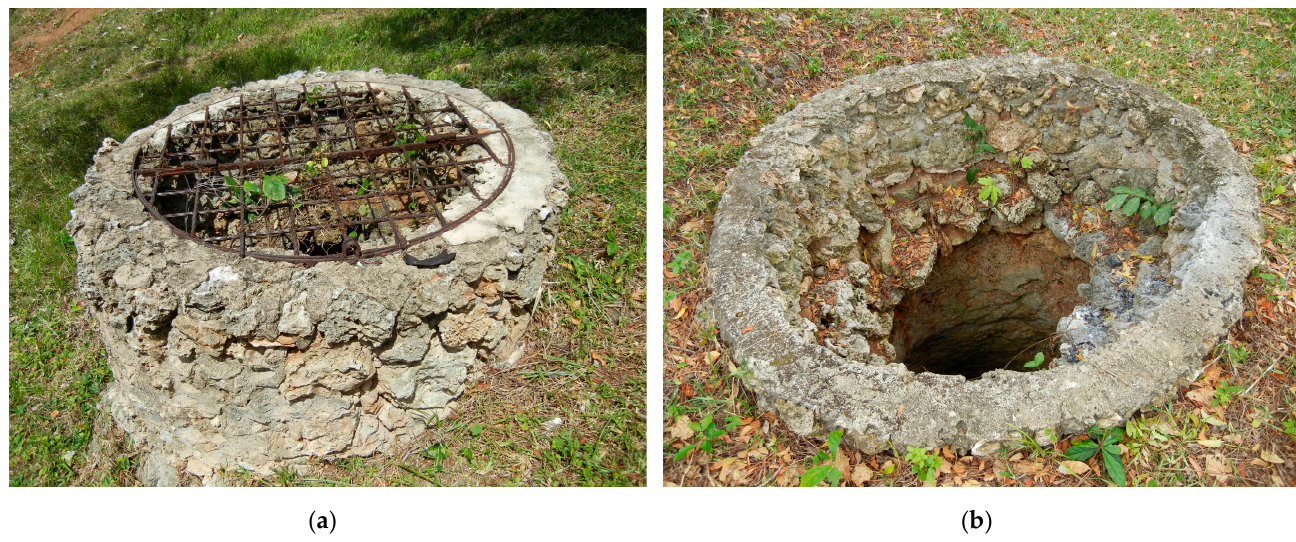
Figure 4. Examples of some types of wells in the precolonial town of Jumba la Mtwana, Kenya. Photos by the author, 2021. ( a ) A well near the center of the town. ( b ) An example of a well found by the houses.